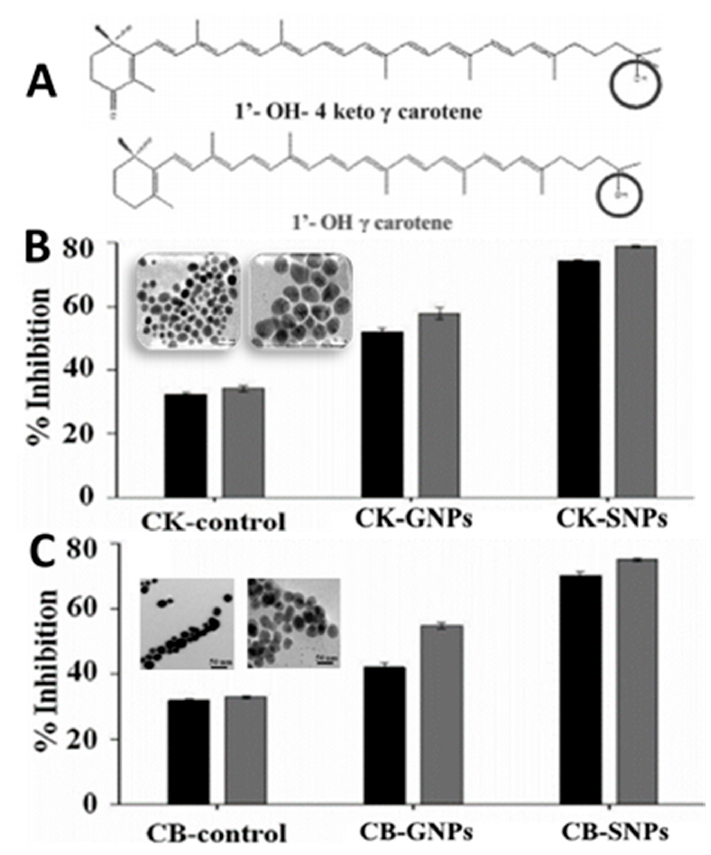
Figure 14. Chemical structures of 1 ′ -OH-4 keto γ -carotene and 1 ′ -OH γ -carotene ( A ) used for synthesis of gold nanoparticles and silver nanoparticles along with their nitric oxide and 2,2-diphenylpicrylhydrazyl free radical scavenging activity shown by 1 ′ -OH-4 keto γ -carotene based gold and silver nanoparticles ( B ) as well as 1 ′ -OH γ -carotene based gold and silver nanoparticles ( C ) compared to the control. The results were expressed as mean ± standard deviation of ≥ 3 independent replicates and error bars represent the standard deviation from mean values. GNPs = gold nanoparticles, SNPs = silver nanoparticles, CK = 1 ′ -OH-4 keto γ -carotene, CB = 1 ′ -OH γ -carotene. and represent bars corresponding to nitric oxide and 2,2-diphenylpicrylhydrazyl scavenging percentage values, respectively. Adapted with permission from Sowani, et al. [115].